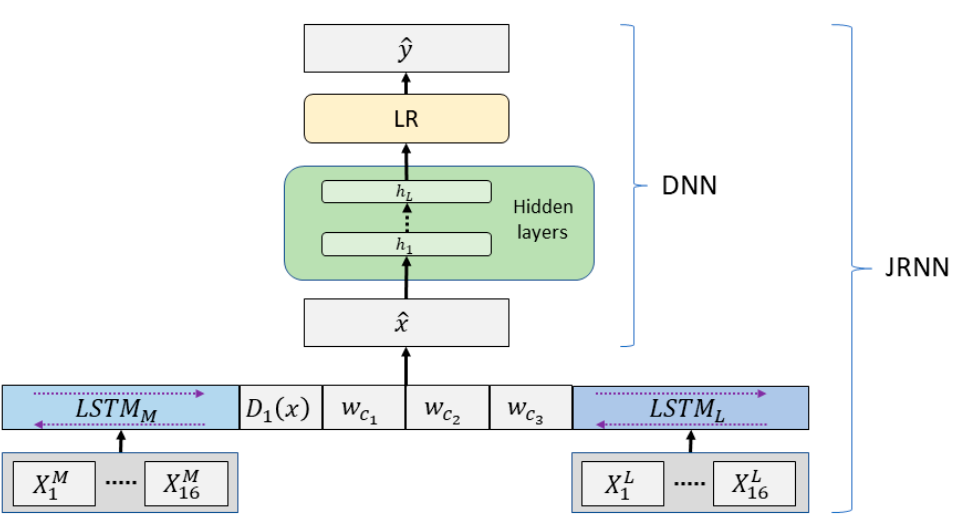
Figure 3. Combined depiction of the DNN and JRNN architectures. In the DNN-only configuration, the set of continuous ,𝑤 (cid:3030) ,𝑤 (cid:3030) [ D p ( x )] and categorical ( 𝑤 (cid:3030) ) predictors (Equation (2)) are provided as input 𝑥(cid:3548) . In the JRNN configuration, the (cid:3117) (cid:3118) (cid:3119) condensed vector representations of imagery time-series created by the joint LSTM networks are concatenated with the D 1 ( x ) set of continuous biophysical variables and categorical ( 𝑤 (cid:3030) to the